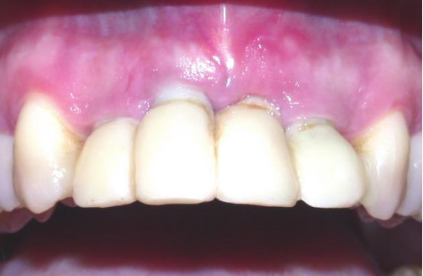
Figure 14: The temporary bridge, three months after